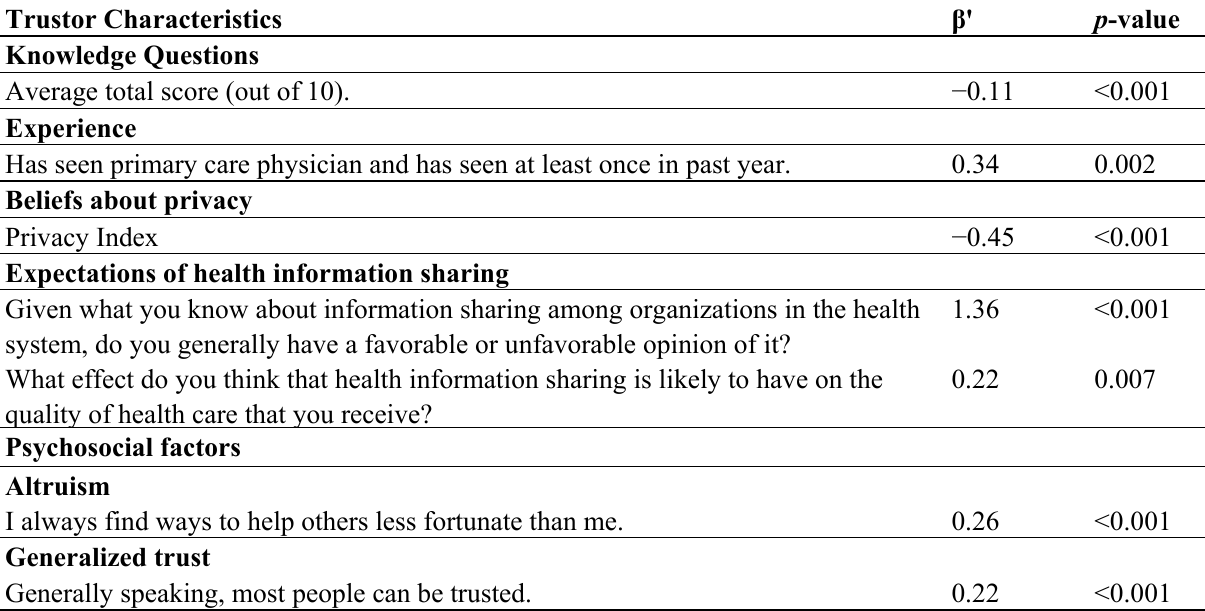
Table 4. Multivariable stepwise regression analysis (Adjusted R 2 =